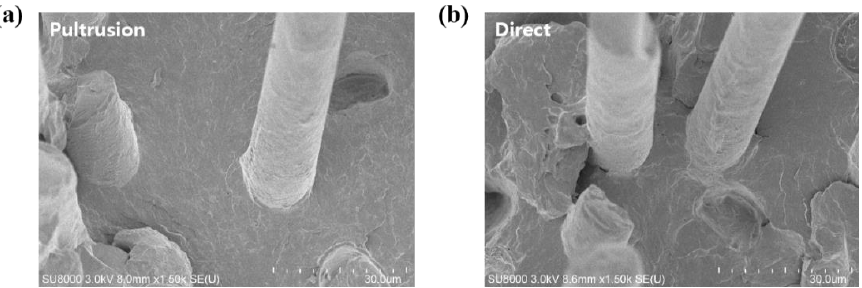
Figure 11. SEM images of the GF/PA6 interface from the pultrusion and direct extrusion processes: ( a ) pultrusion; ( b ) direct. Table 6. Mechanical properties of the GF/PA6